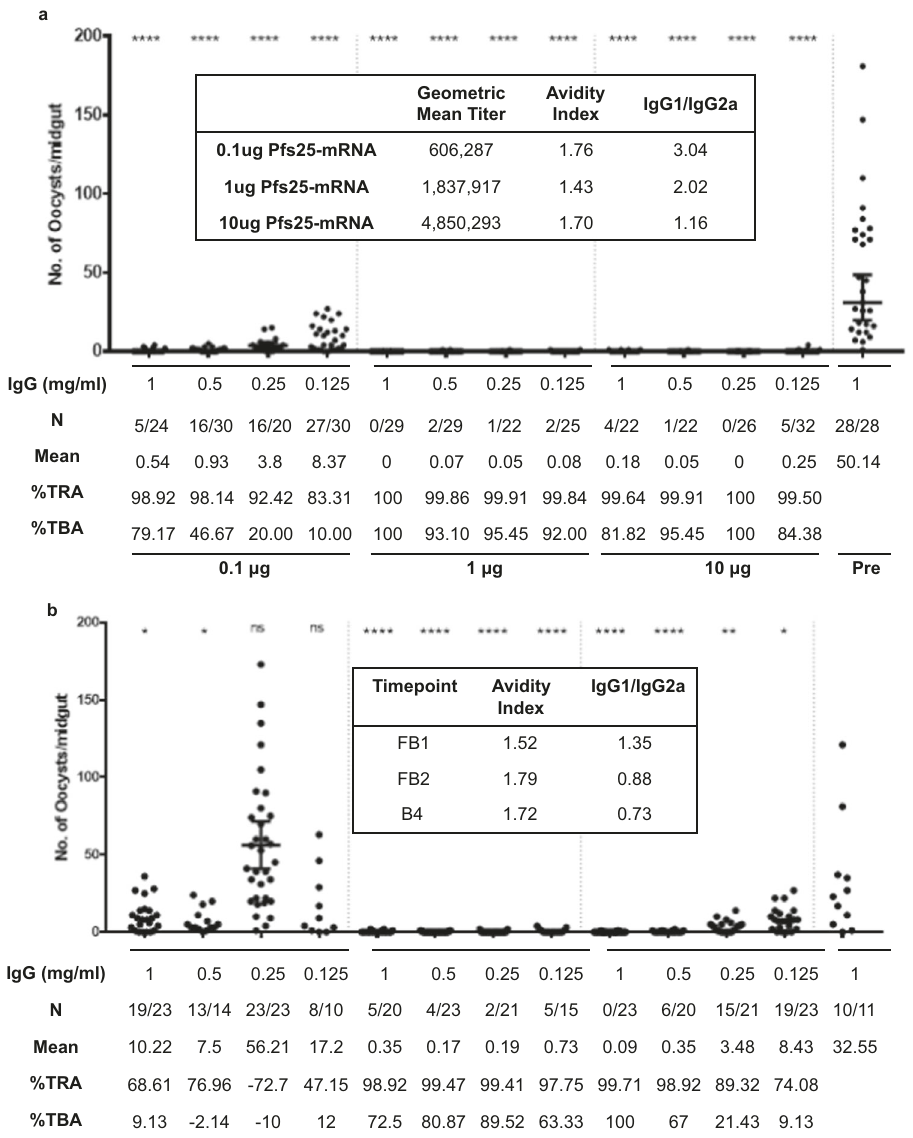
(Fig. 6a – c). Figure 7b shows the results of transmission-blocking SMFA in the presence of puri fi ed IgG from mice immunized with 10 μ g Pfs25 mRNA-LNP. IgG from sera after a single immunization (FB1) revealed only modest TRA. However, IgG from mice immunized two (FB2) or three times (B4) exhibited robust TRA. The Fig. 7b inset also shows data on antibody avidity and isotype for each bleed with results similar to those in earlier studies (Fig. 4). Results of protection against sporozoite challenge in groups of mice immunized with various regimens of 10 μ g PfCSP